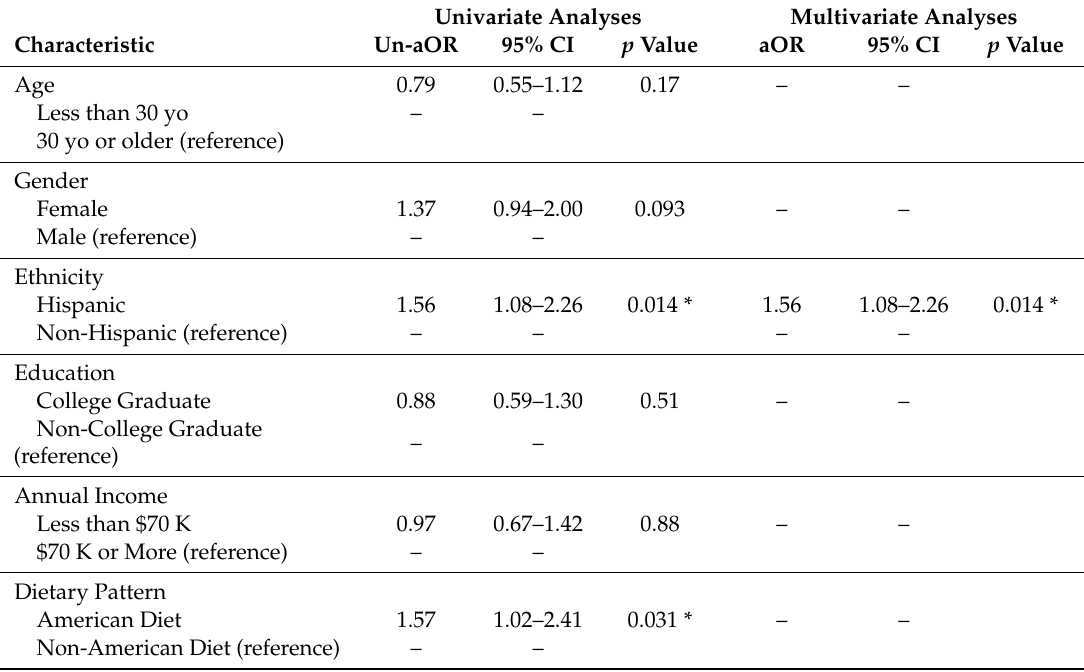
Table 2. Univariate and multivariate analyses of biopsychosocial and dietary characteristics associated with obesity.